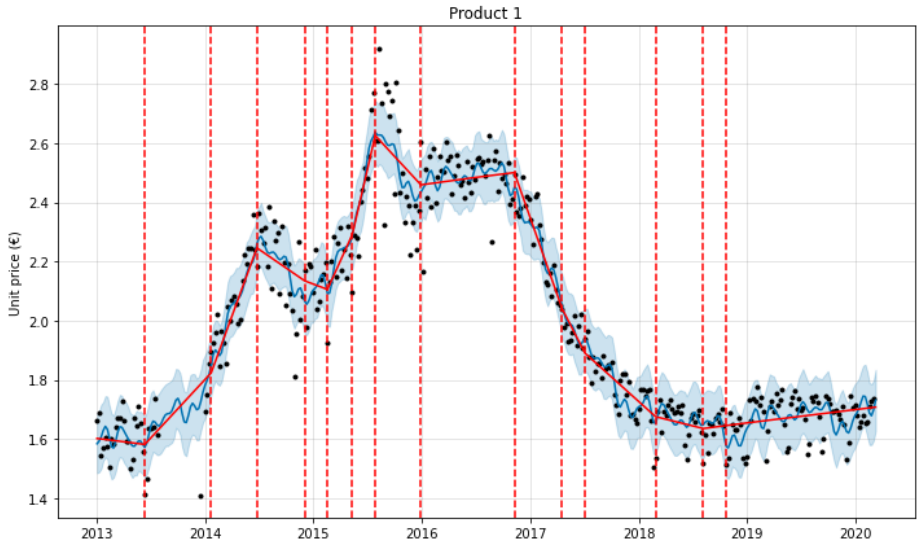
Figure 6. Prophet fit over the entire product 1 dataset. The actual fit is shown in light blue, the red line shows the trend function, while trend changepoints are indicated by red dashed vertical lines.